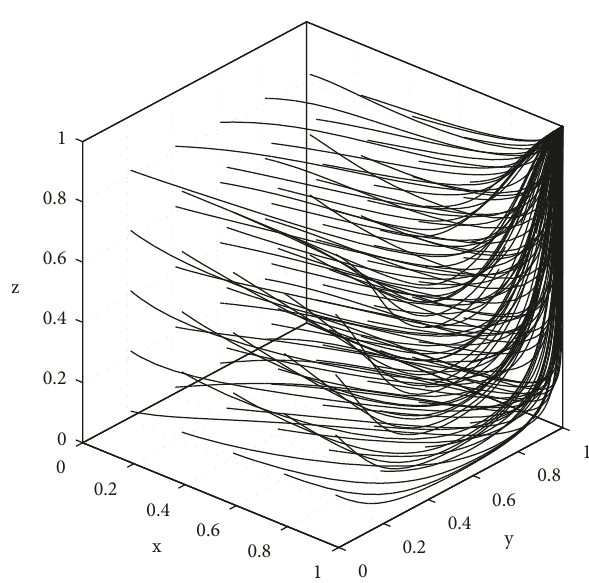
Figure 6: Dynamic evolution path of case